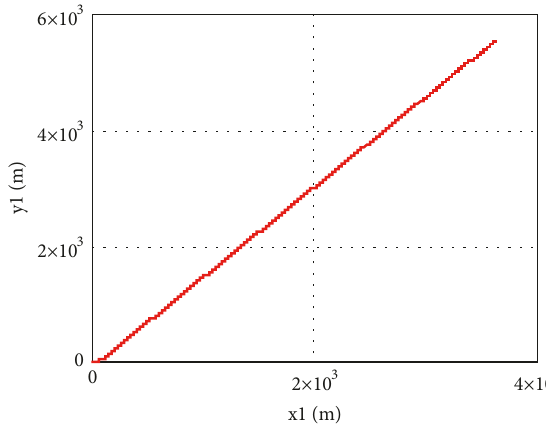
Figure8:Vesseltrajectoryduringslowedrotationatagivenheading